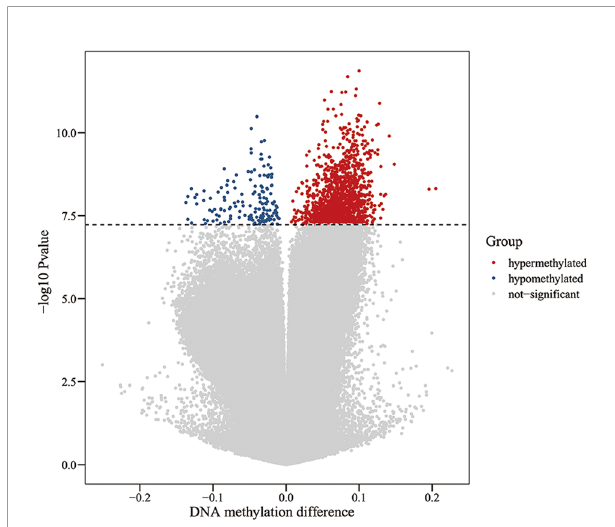
FIGURE 1 | Volcano plot for differential DNA methylation analysis of ICH group and control group. The x-axis shows the DNA methylation difference (delta b ), the y-axis shows the – log10 p-value of each CpG site. The dashed line indicates statistically signi fi cant (P <5.92 E-08). Red represents hypermethylation sites, blue represents hypomethylation sites, and gray represents no signi fi